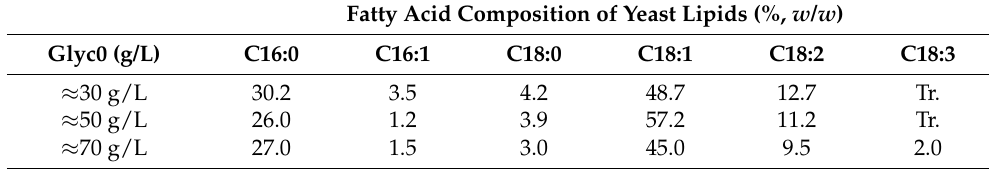
Table 6. Fatty acid composition of the cellular lipids produced by Cryptococcus curvatus ATCC 20509, when cultivated on crude glycerol in shake-flask experiments and when various initial glycerol concentrations were used. Time of fermentation for the determination of the fatty acid composition was between 170 and 220 h after inoculation. Culture conditions as in Table 2. Tr.: traces (<0.5%). Fatty Acid Composition of Yeast Lipids (%, w/w ) Glyc0 (g/L)